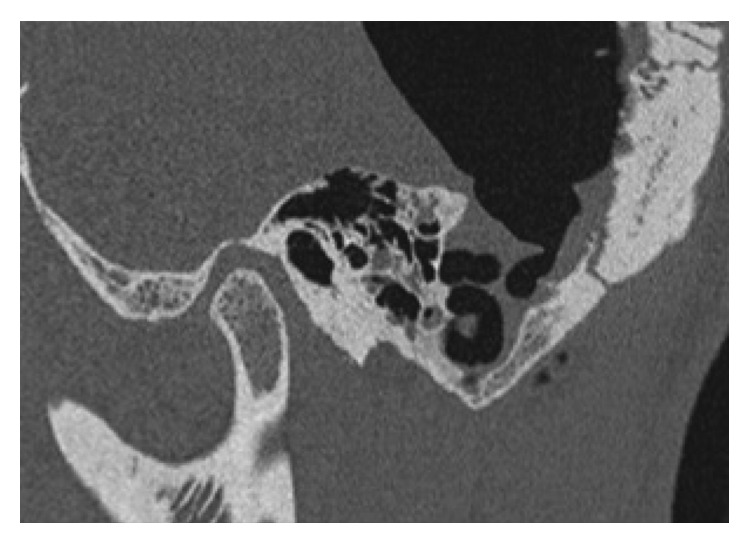
Sagittal CT view.